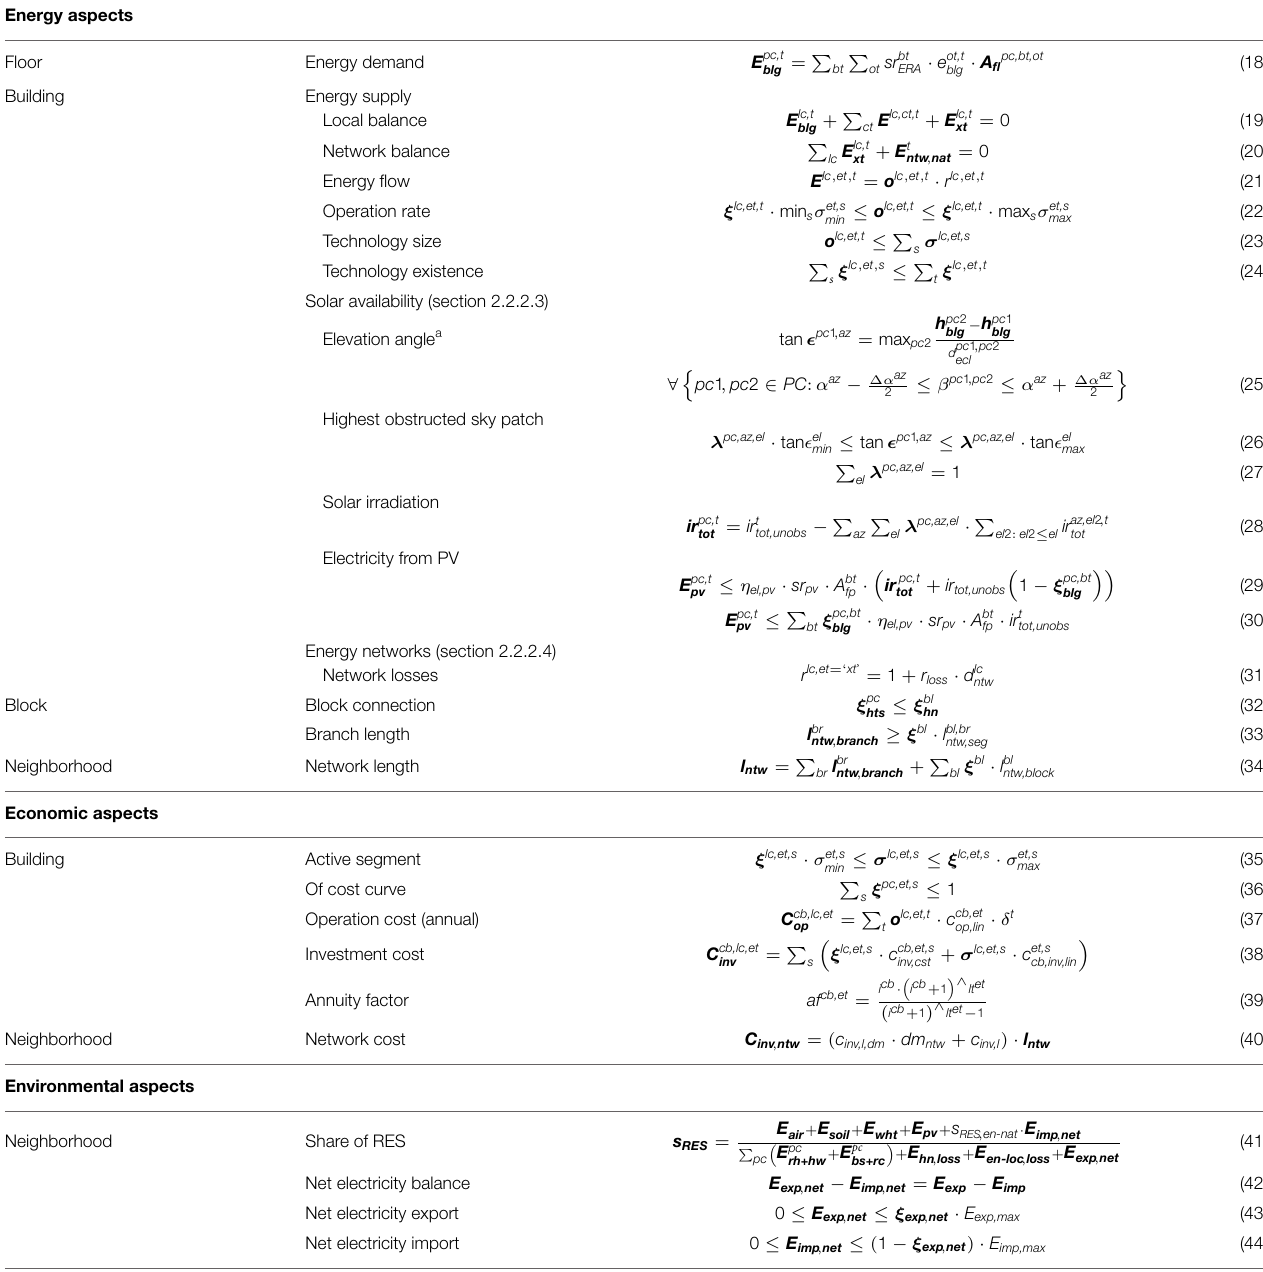
TABLE 2 | Model equations for energy, economic, and environmental